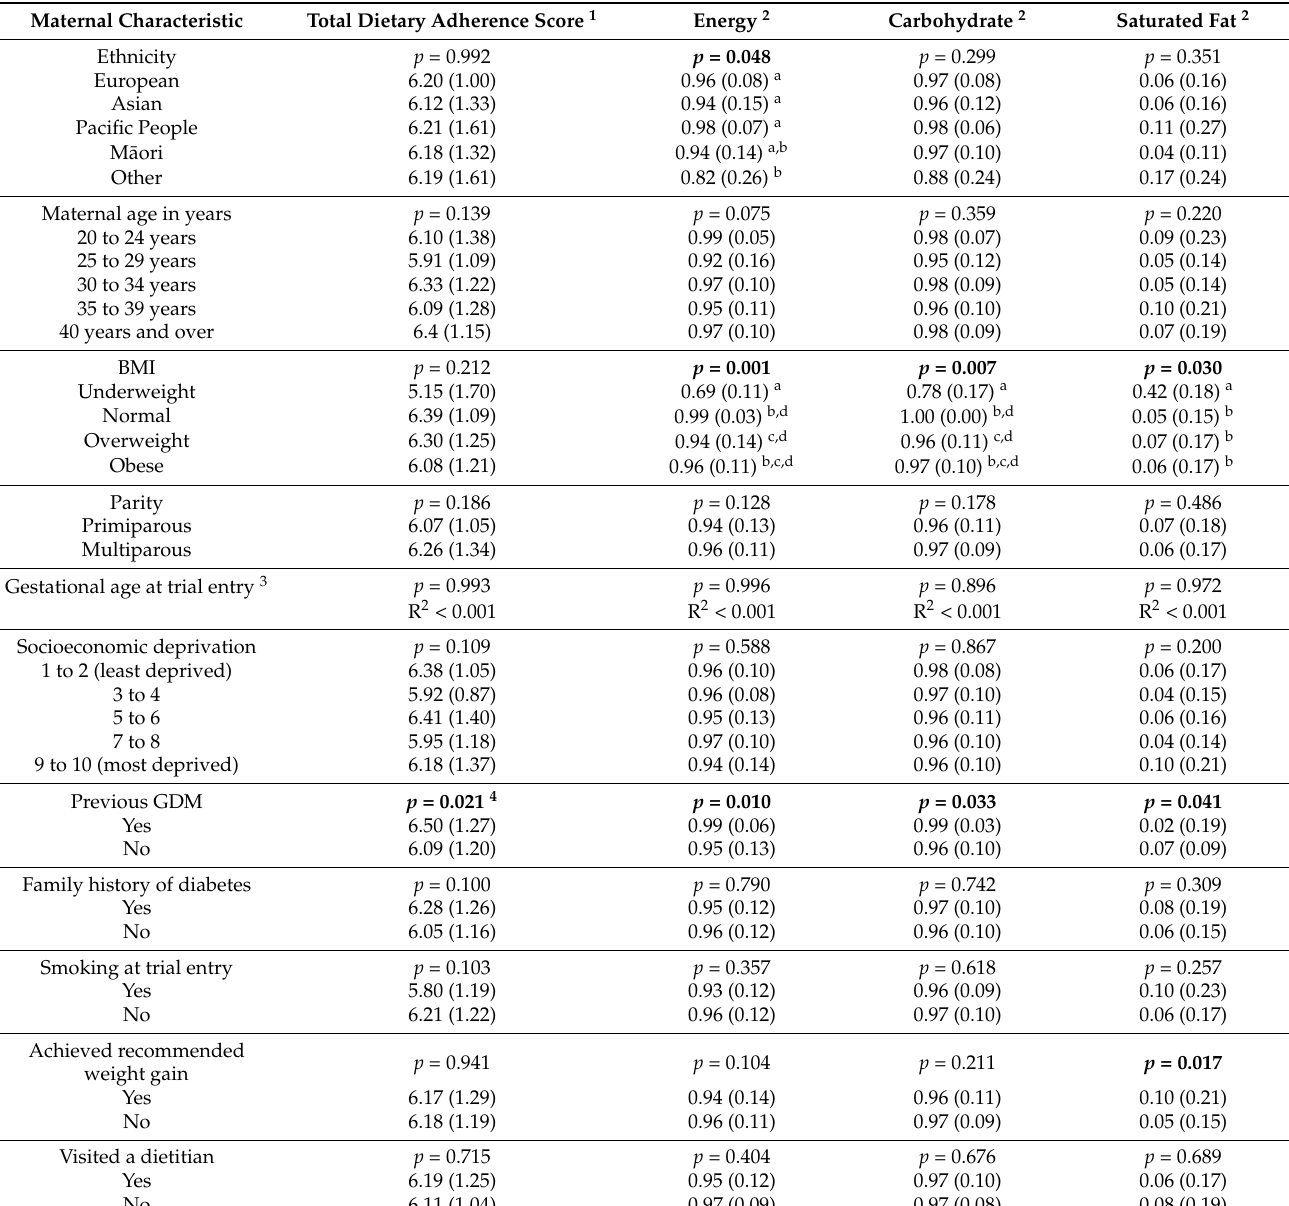
Table 4. Dietary adherence scores for energy, carbohydrate, and saturated fat intake, and association with maternal sociodemographic characteristics.